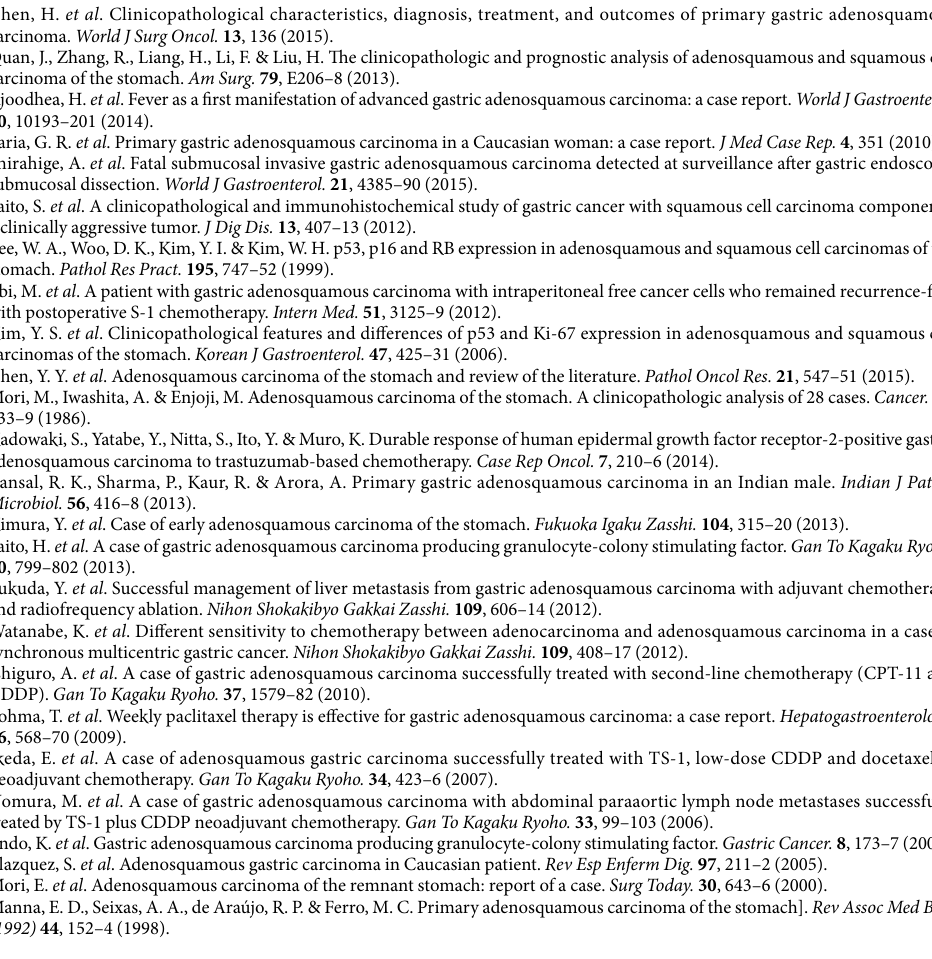
Data were processed using SPSS 22.0 for Windows (SPSS Inc., Chicago, IL, USA). Discrete variables were analyzed using Chi-square test or Fisher’s exact test. Significant prognostic predictors for patients identified by univariate analysis were further assessed by multivariate analysis using the Cox’s proportional hazards regression model. OS was shown by Kaplan-Meier method. The P value was considered to be statistically significant at 5% level.